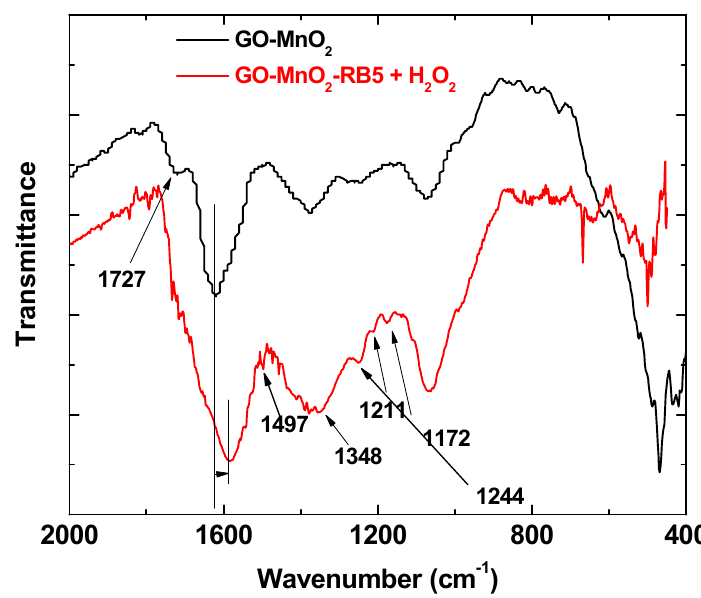
Figure 8. FTIR spectra of GO ‐ MnO 2 before and after RB5 adsorption.